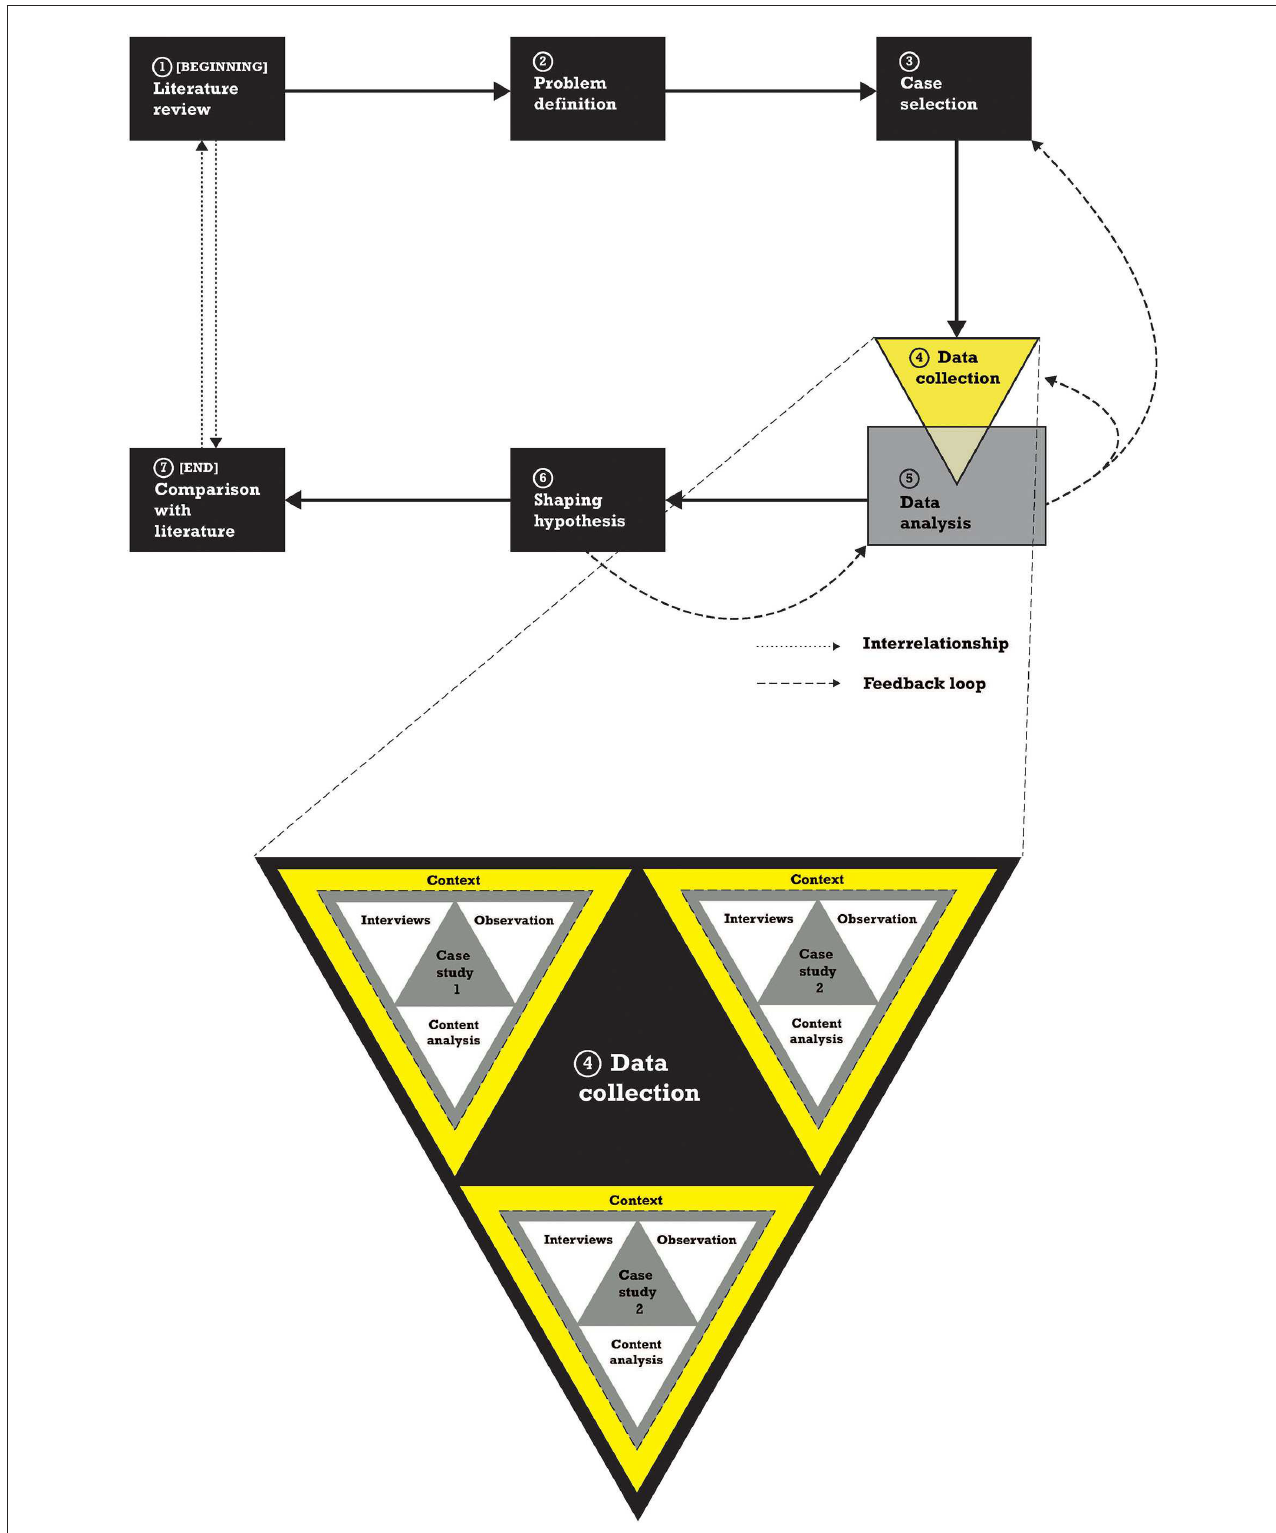
FIGURE1 Illustration of the research process applied within this study (adapted from Eisenhardt, 1989 roadmap for building theory from cases).